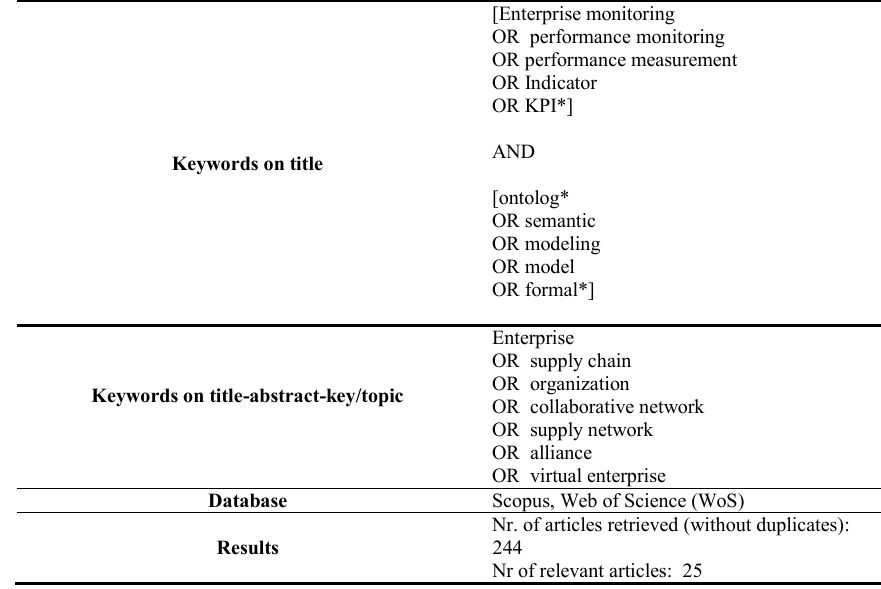
Table 1. Method adopted for literature